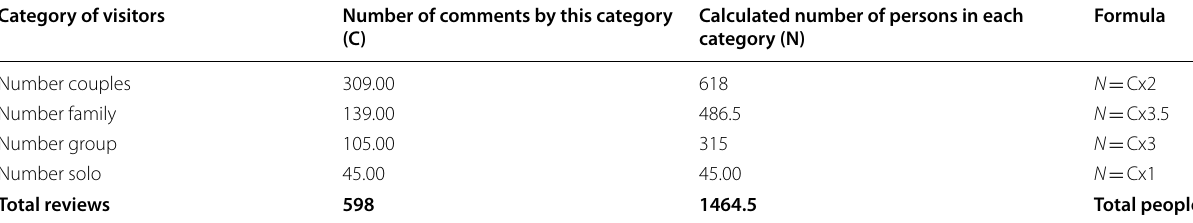
Table 1 Method of estimation for the number of guests in Al-Misfat guest houses Category of